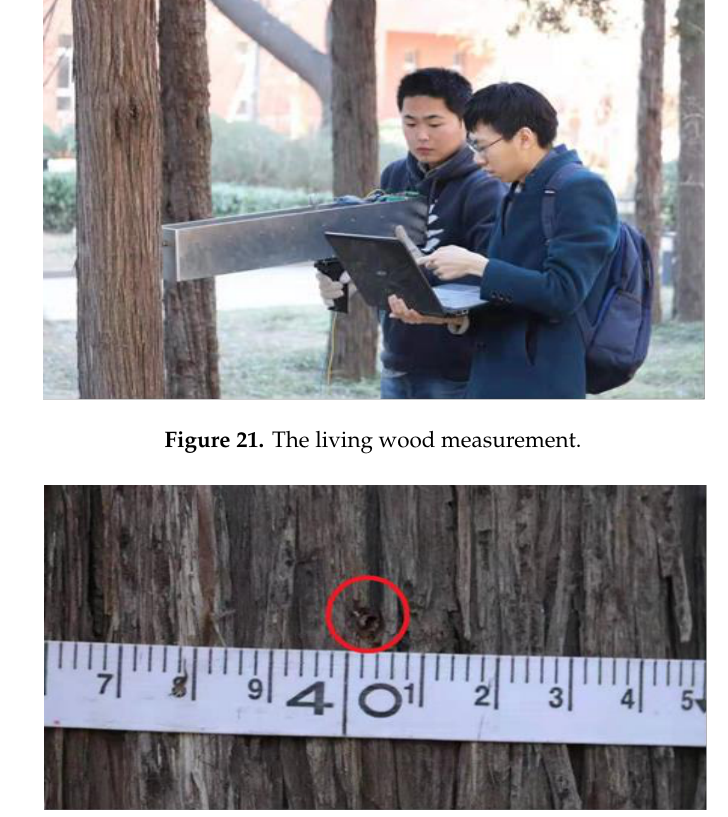
Figure 22. The drill hole after the measurement. The minimum length of a scale division is 2 mm.